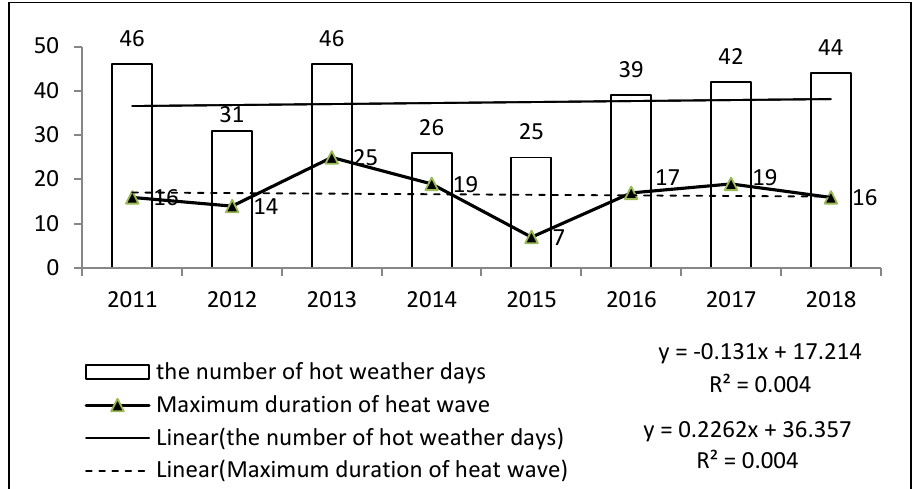
Figure 1. Number of hot weather days and maximum heatwave duration in the administrative center of Pengshui County in July and August from 2011 to 2018. Note: 1 Hot weather was defined as a maximum daily temperature of more than 35 °C, and heatwave was defined as hot weather continuing for more than three days; 2 The data source was the daily maximum temperature data of the National Meteorological Information Center of China (http://data.cma.cn/).